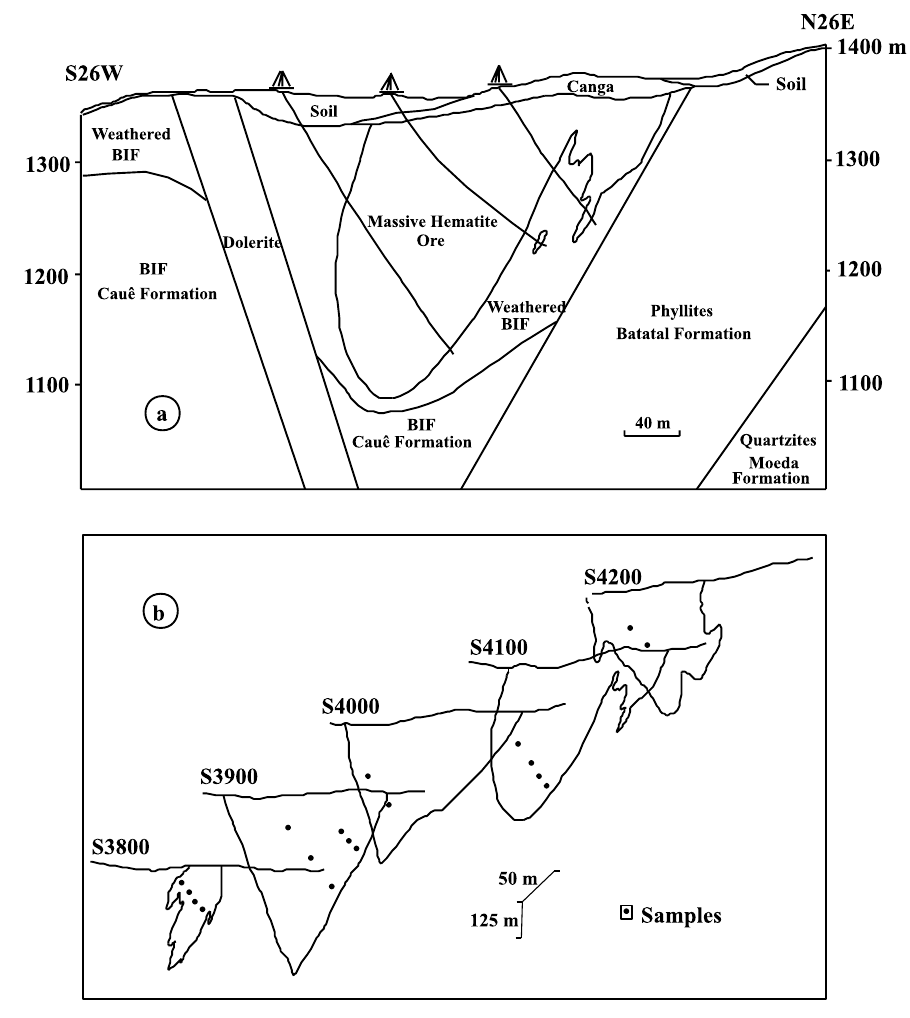
Fig. 2 – (a) Local geologic section of the Capitão do Mato Mine, showing the massive hematite ore intercepted by boreholes and (b) the localization of the samples chosen for porosity